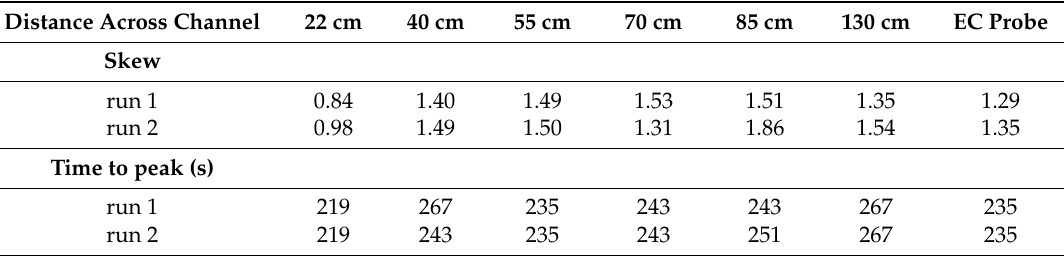
Table 4. Weierbach. Tracer results for skewness and time to peak.